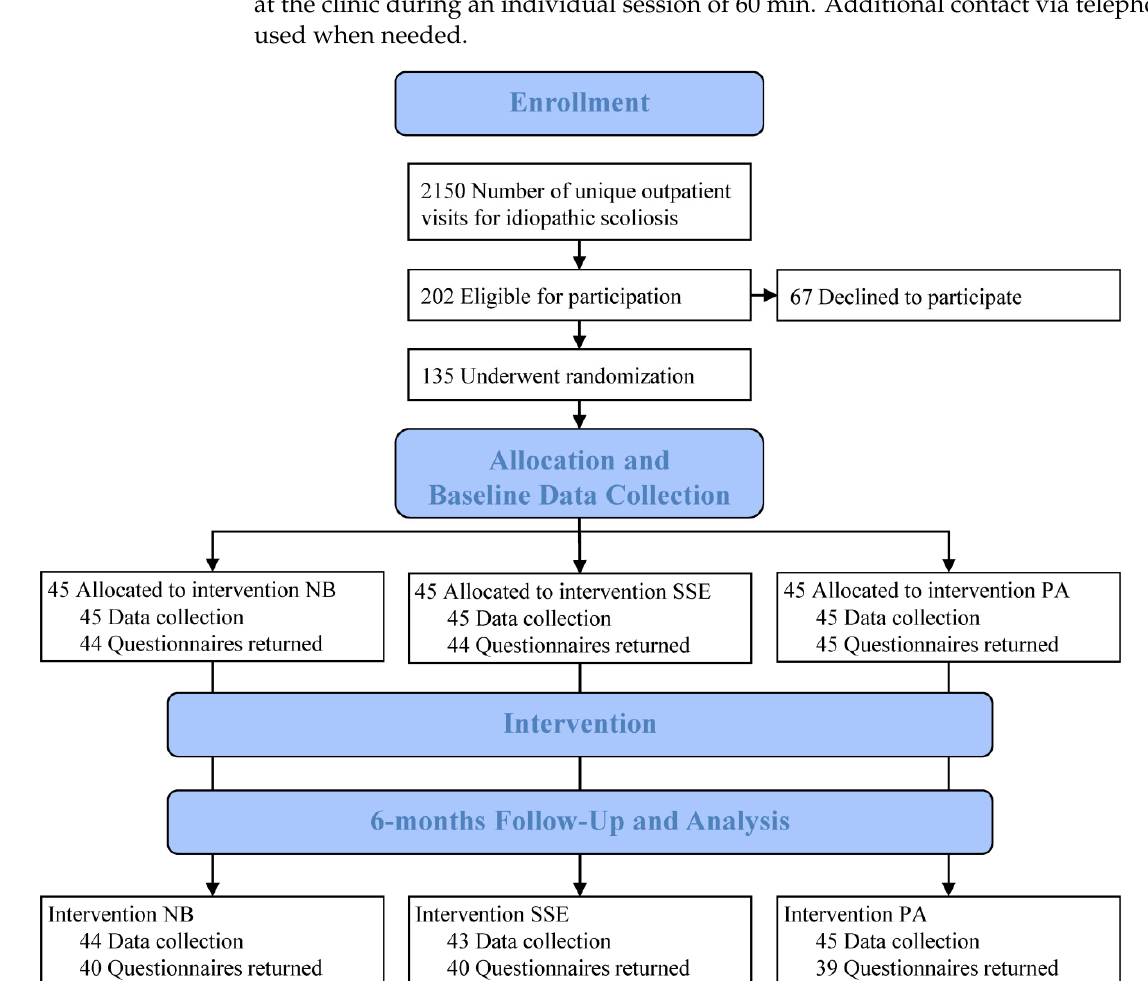
Figure 1. CONSORT flow diagram of the participants with AIS in the study.